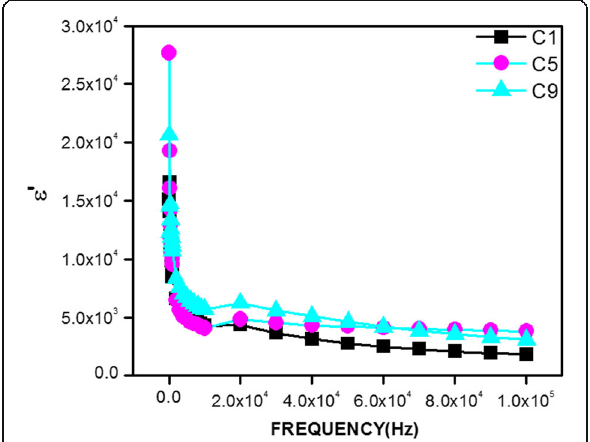
Fig. 3 Variation of ε ′ with frequency for C1( x =0.1, y =0.45), C5( x =0.5, y =0.25), and C9( x =0.9, y =0.05)